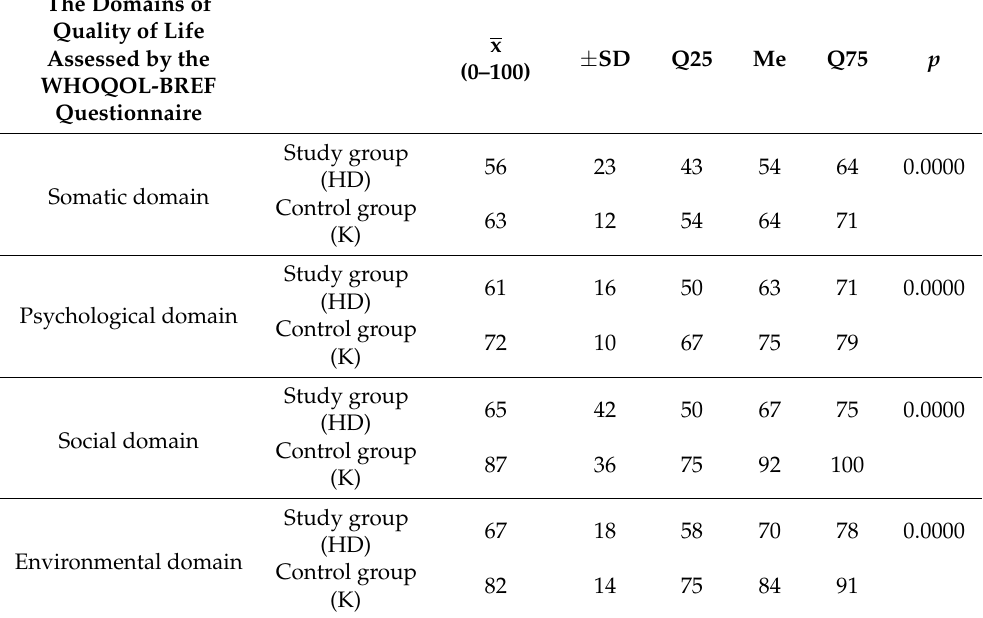
Table 3. Comparison of somatic, psychological, social, and environmental domains assessed by